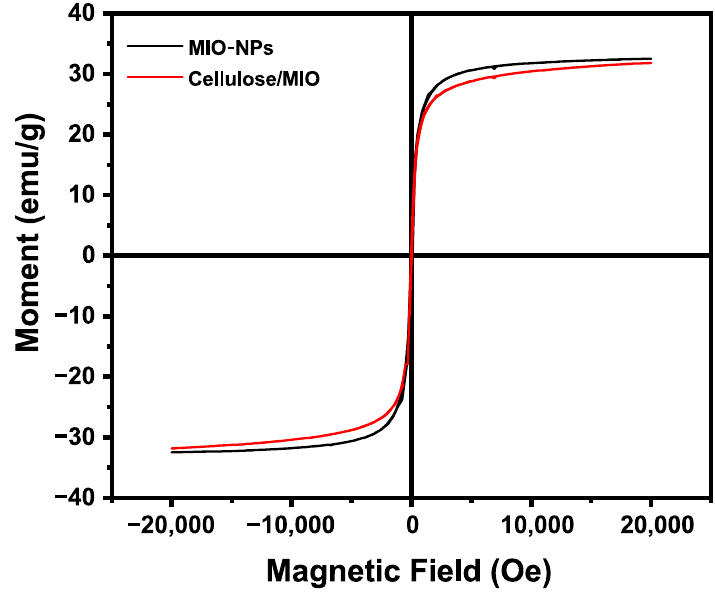
Figure 9. Magnetic properties of MIO-NPs and Cellulose/MIO-NCPs.